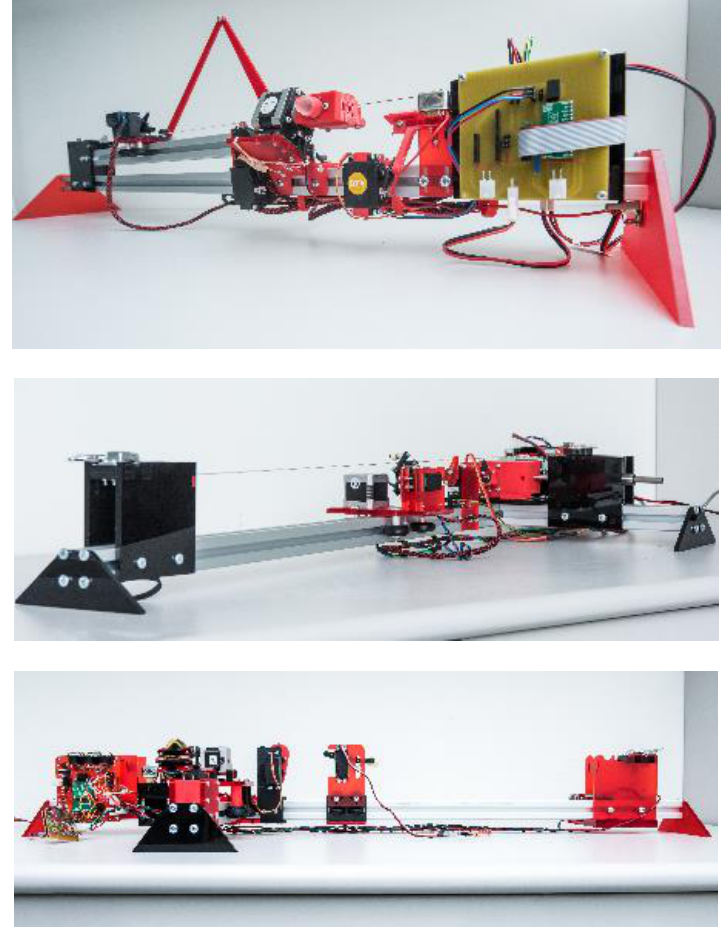
Fig. 14. Final designs, groups I, II, and III (top to